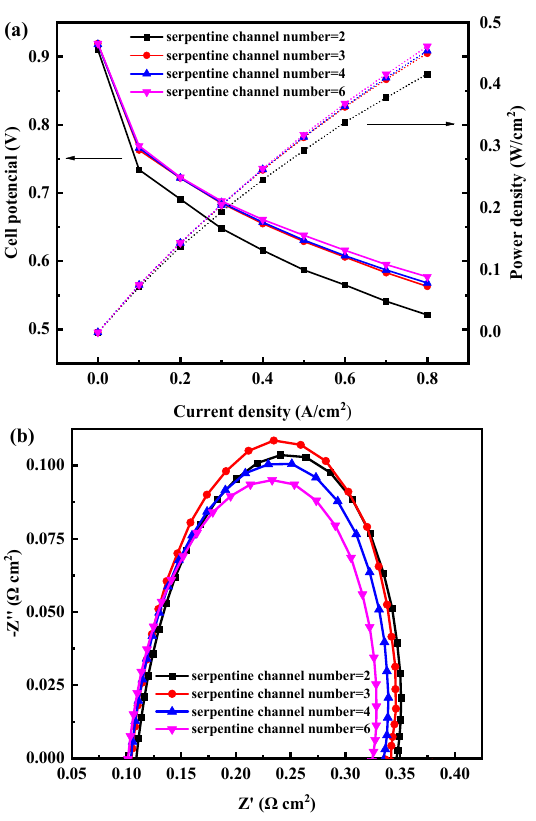
Figure 3. ( a ) Polarization curves and ( b ) power density curves of the open-cathode PEMFC with different anode serpentine channel numbers.